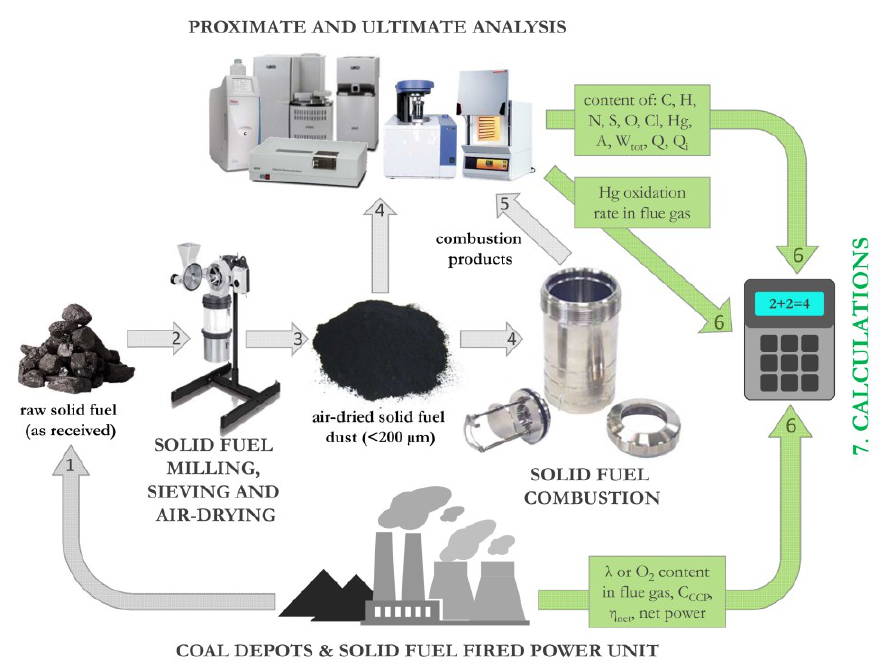
Fig. 1. The scheme of the lab-scale mercury emission assessment procedure (numbers in the arrowheads present suggested sequence of